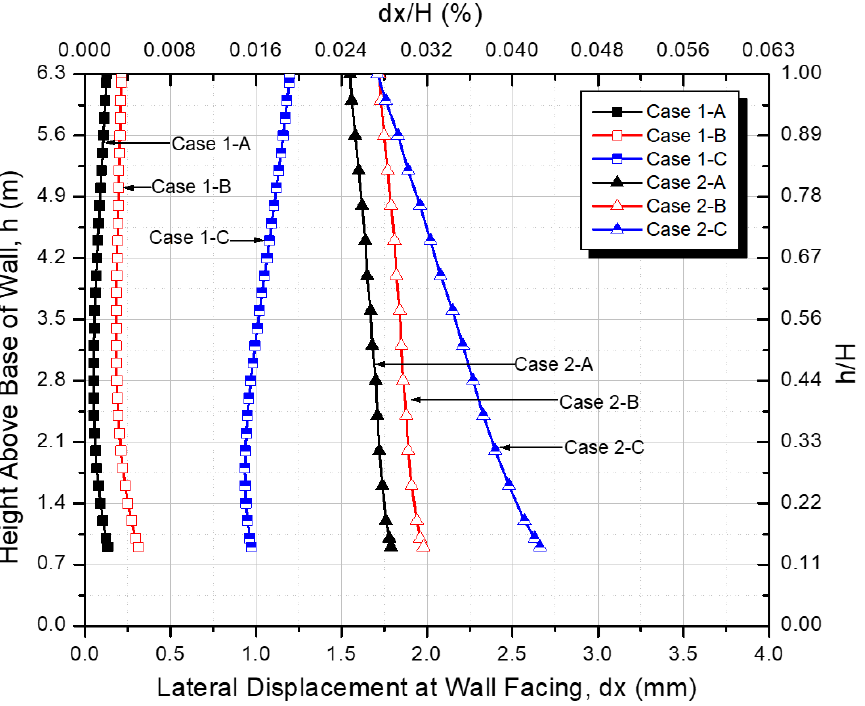
Figure 3. Lateral Displacement at Wall Facing.